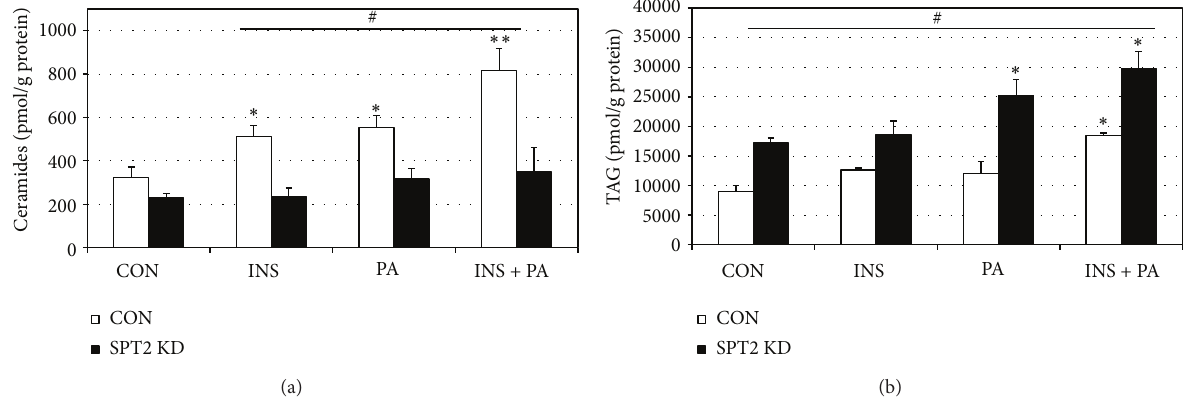
Figure 4: Following SPT2 knockdown, myotubes were treated with insulin (INS, 50 nM), palmitic acid (PA, 0.5 mM), or both (INS + PA). (a) Ceramides were significantly comparably elevated with INS and PA treatments, but not with SPT2 KD ( ∗ 𝑃 < 0.05 , treatment versus control). Both treatments together (INS + PA) resulted in an additive increase in ceramides ( ∗∗ 𝑃 < 0.05 , INS + PA versus INS and PA). SPT2 KD prevented treatment-induced increases in ceramide ( # 𝑃 < 0.05 , CON (scramble) versus SPT2 KD). (b) TAG levels were elevated in PA and INS + PA treatments ( ∗ 𝑃 < 0.05 , treatment versus control). SPT2 KD increased TAG in every condition ( # 𝑃 < 0.05 , SPT2 versus CON (scramble)).